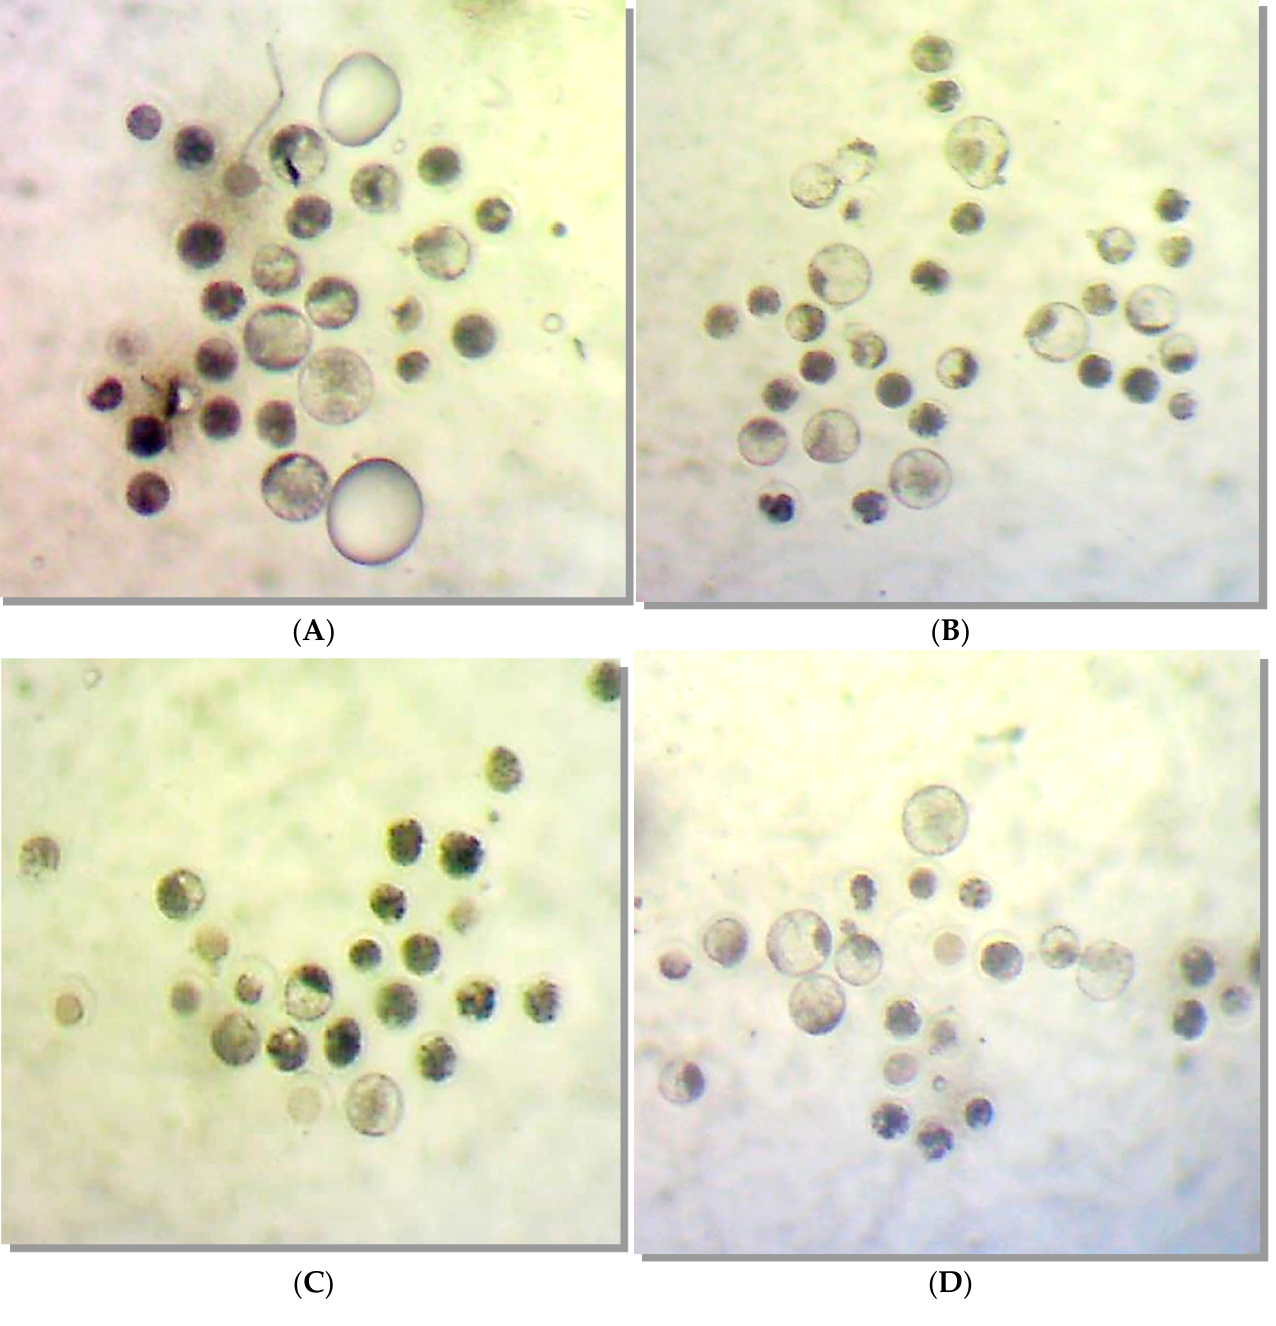
Figure 1. Illustrations of the in vitro bovine embryos developed in each one of the cultivated drops (Experiment 1/IVP Replicate 1.3) for each treatment group: ( A ) Group 1, ( B ) Group 2, ( C ) Group 3, and ( D ) Group 4. The size difference observed between the structures is due to the enlargement/reduction of the photo, depending on the number of embryonic structures present in each photo. The objective here is to illustrate the morphological characteristics and degrees of the embryos